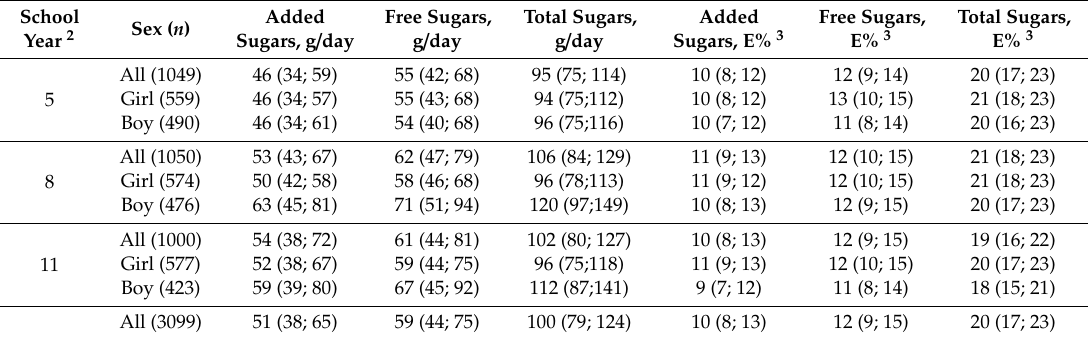
Table 2. Added and free sugars median (p25; p75) intakes 1 in Swedish adolescents by school year and